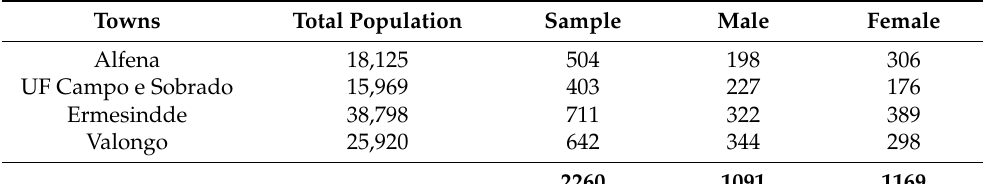
Table 1. Characterisation of the